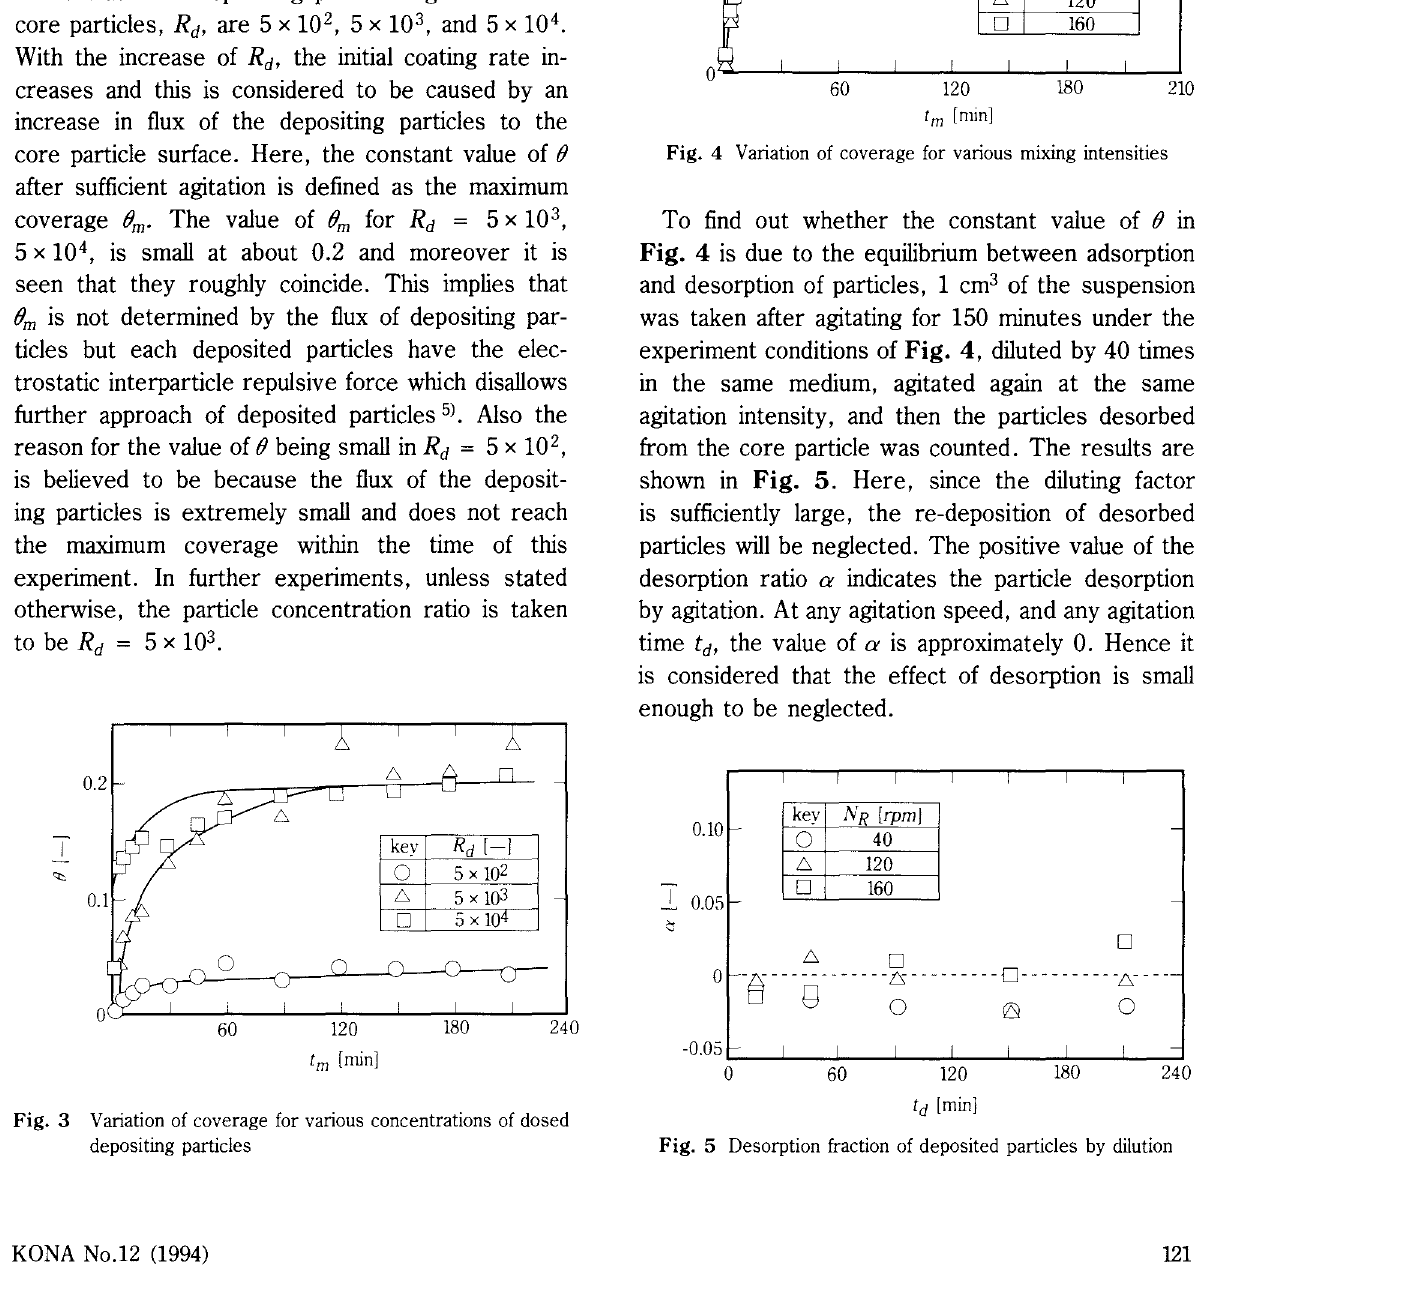
Fig. 5 Desorption fraction of deposited particles by